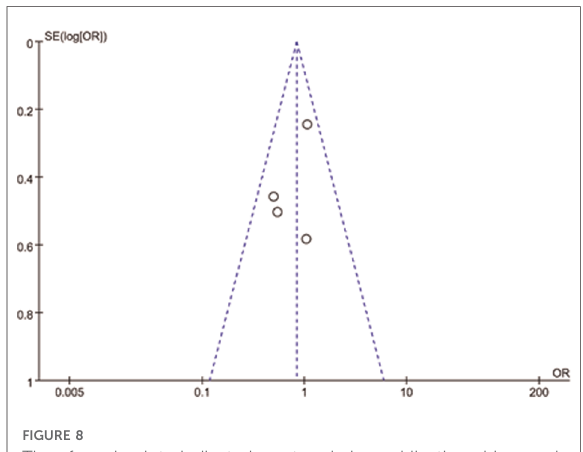
FIGURE 8 The funnel plot indicated a trend in publication bias and